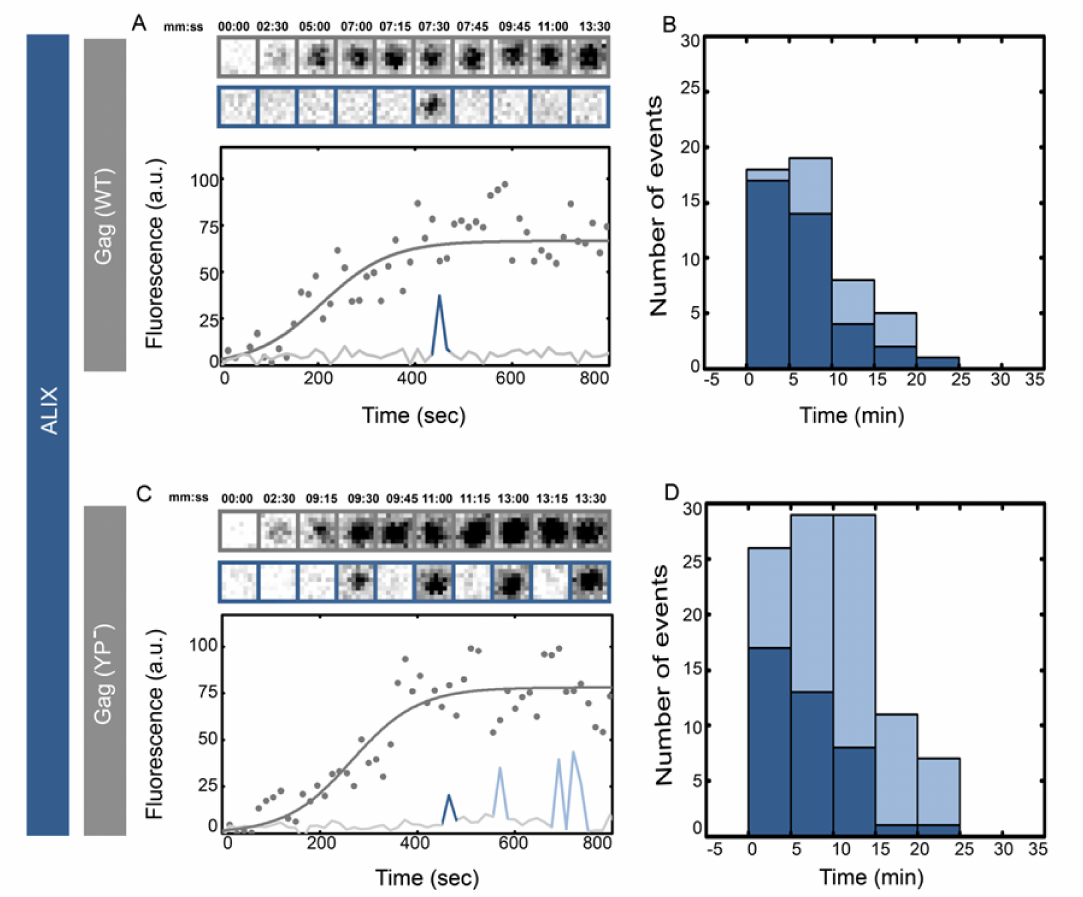
Figure 1. Single versus multiple transient recruitments of ALIX into HIV Gag VLPs versus HIV Gag (YP − ) VLPs. HeLa cells stably expressing ALIX–h30–eGFP were transfected with 1500 ng of Gag–mCherry ( A , B ) or Gag (YP − )–mCherry ( C , D ) and imaged 4 h after transfection. Assemblies of individual representative VLPs are shown with intensity plots (as gray dots and fitted with gray line) and cropped TIRF images of the Gag (top, gray) and ALIX (bottom, Blue) for ( A ) Gag-mChery VLPs and ( C ) Gag (YP − )–mCherry VLPs. Histograms of the first time (dark blue) and later recruitments (light